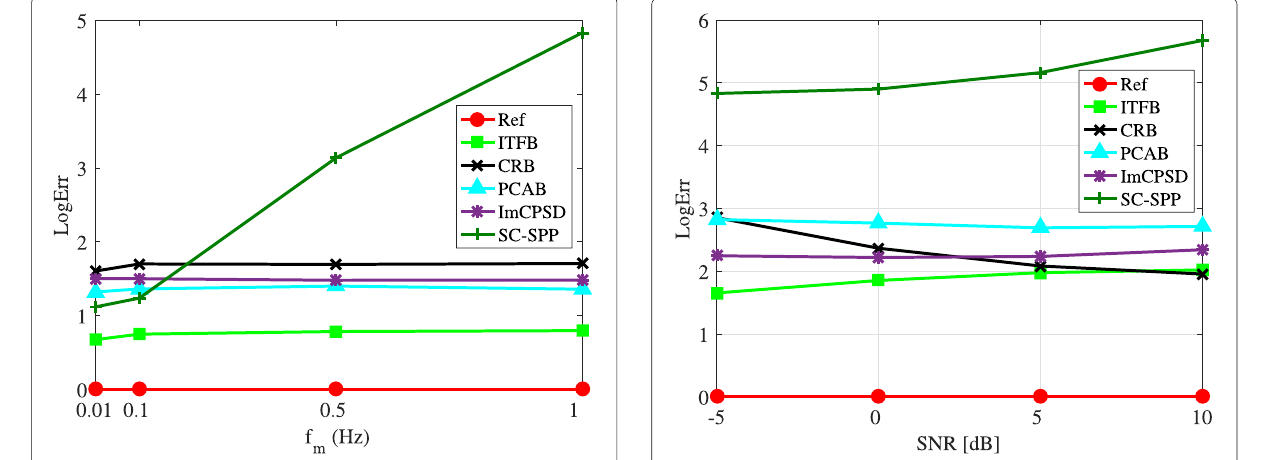
Fig. 5 Comparison of LogErr averaged over all frame indices and frequency bins as a function of the modulation frequency of dynamic noise. SNR = − 5 dB, θ = − 90 ◦